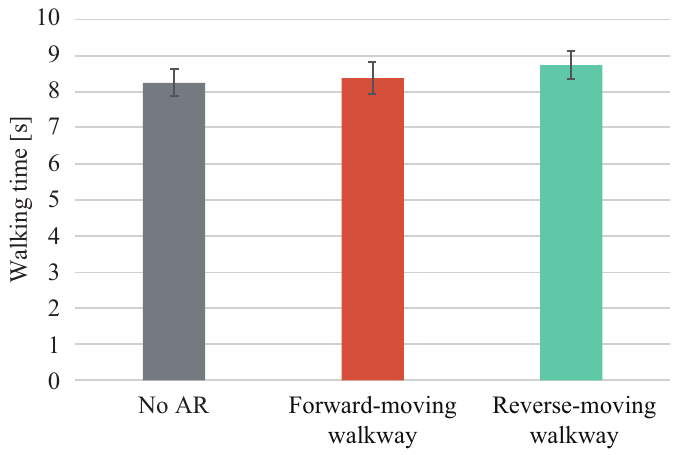
Figure 18. Results of the walking time.